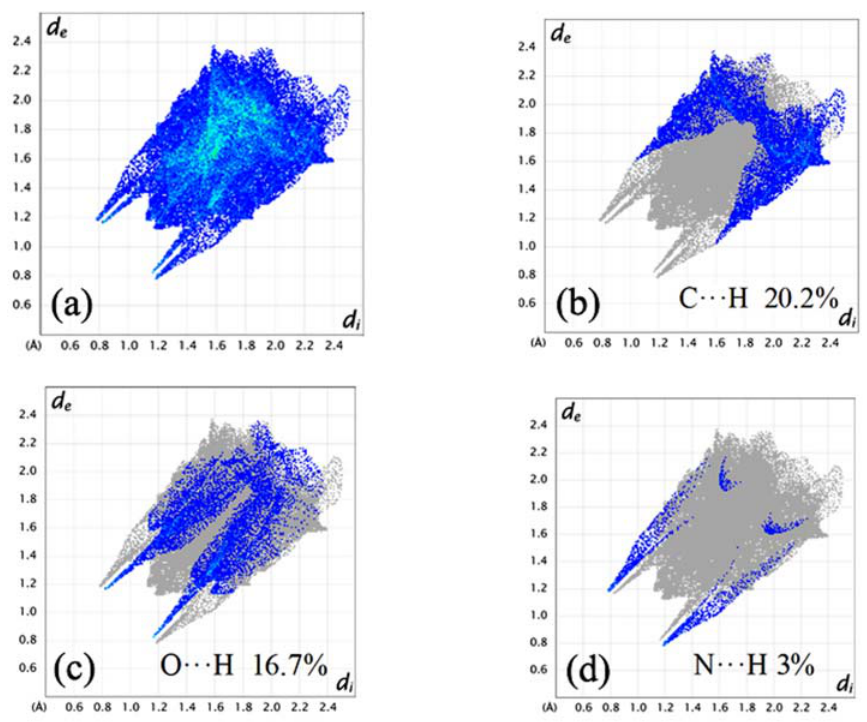
Fig. 12. 2D Finger print plot of Str 302with a) 100% contribution of all elements b) 25.7% of C···H/H···C interaction c) 17.5% O···H/H···O interac- tion d) 3% of N···H/H···N